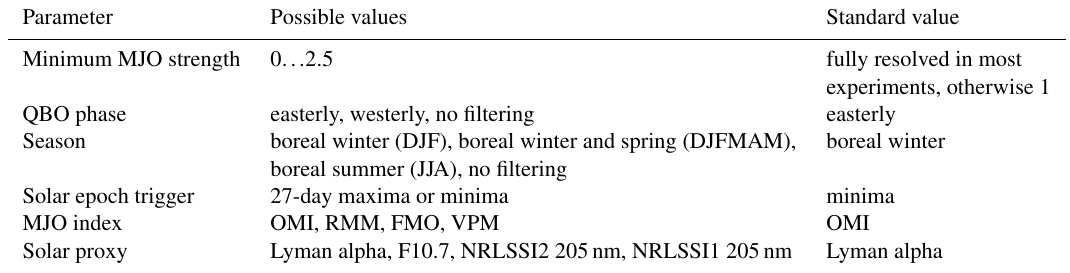
Table 1. Parameters varied to quantify their influence on the possible relation between the solar 27-day cycle and the MJO phase evolution. Parameter Possible